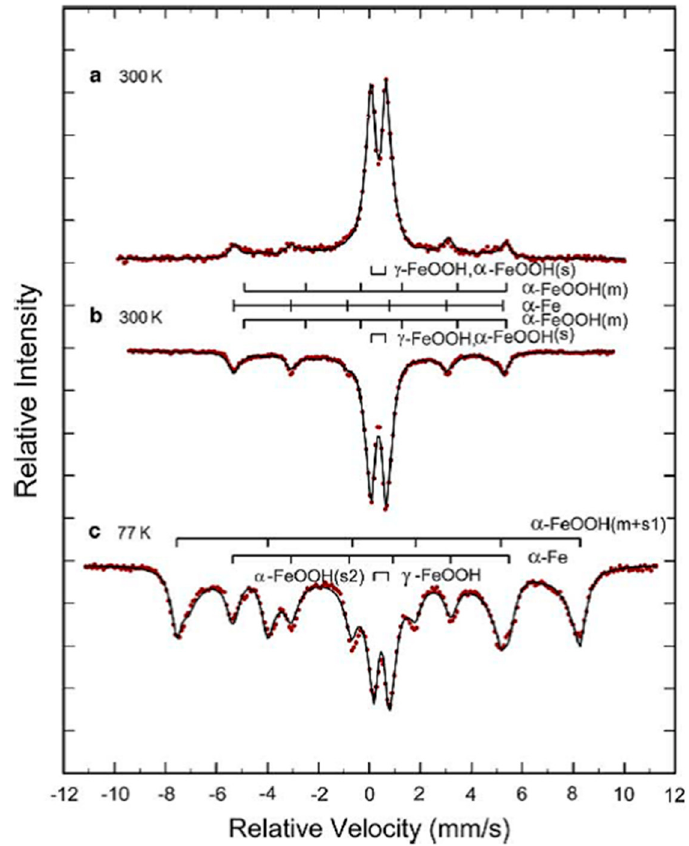
Figure 15. Mössbauer spectra measured at room and low temperature of the coating layer formed at the surface of a weathering steel after atmospheric exposure (see text). Reproduced from [39], with permission from Elsevier, 2005.